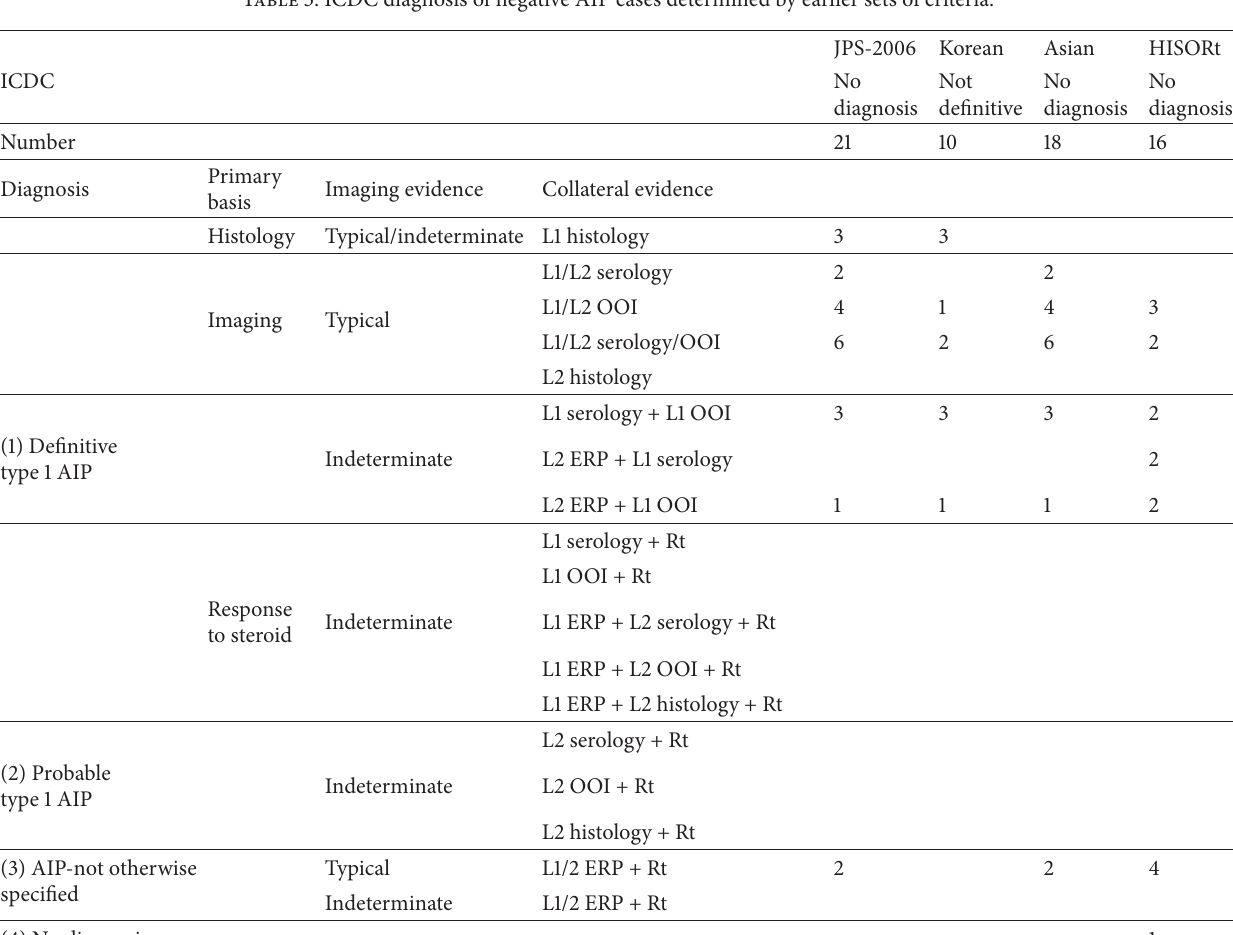
Table 3: ICDC diagnosis of negative AIP cases determined by earlier sets of